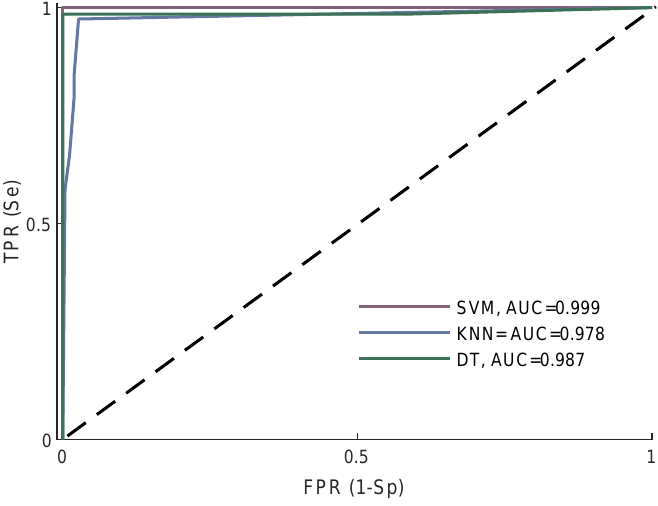
Figure 6. ROC of all classifiers with their best performance. Table 4. The comparison of our study with sate-of-the-art algorithms. * means feature selection was performed before the